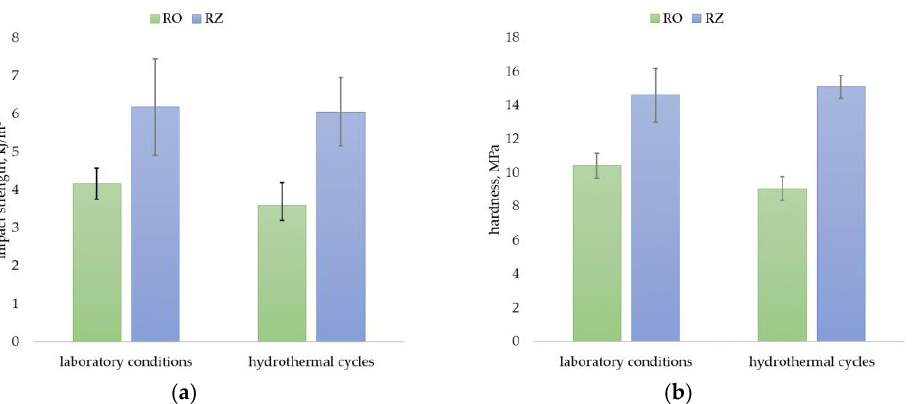
Figure 7. Test results for ( a ) Charpy impact strength, ( b ) Brinell hardness. Error bars represent standard deviation.